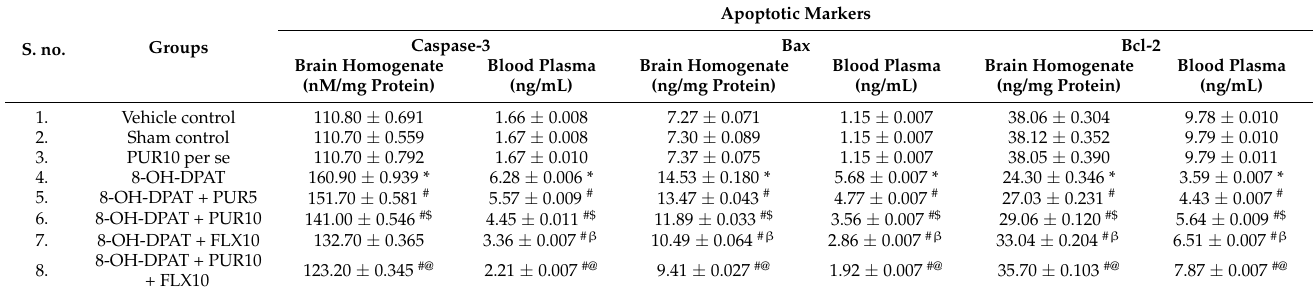
Table 2. Effect of purmorphamine on Caspase-3, Bax, and Bcl-2 levels in 8-OH